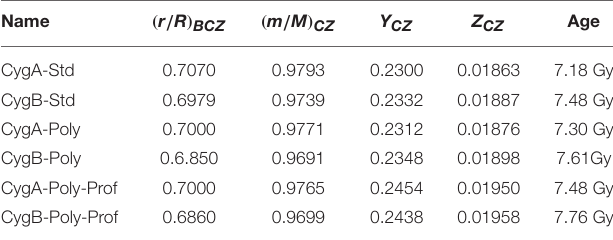
TABLE 6 | Parameters of the 16Cyg models with modified opacities and additional mixing used in this